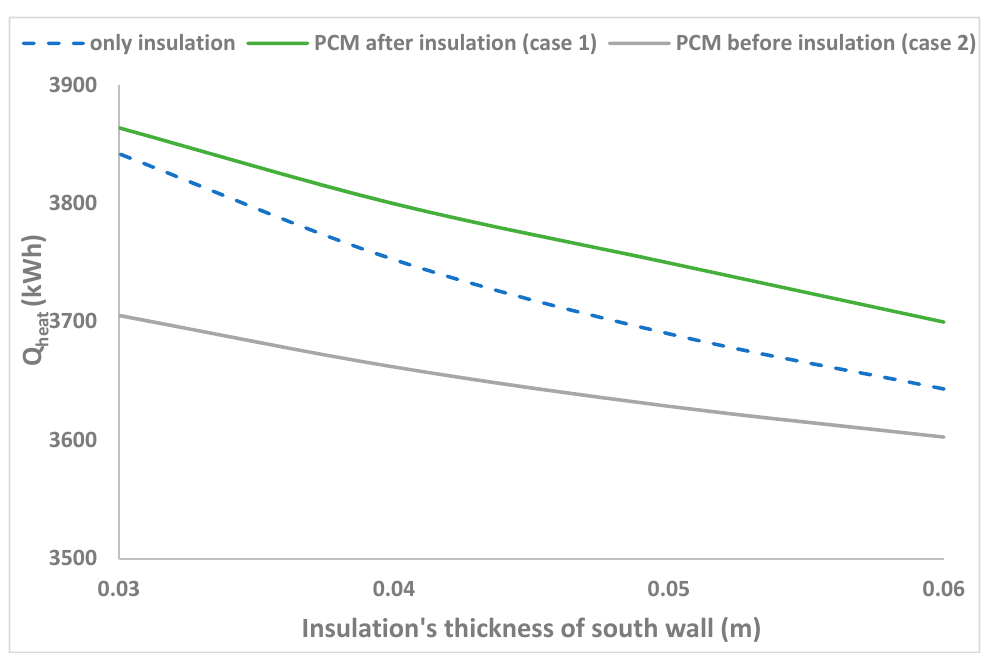
Figure 6. Annual heating loads with PCM in south wall for different insulation scenarios.